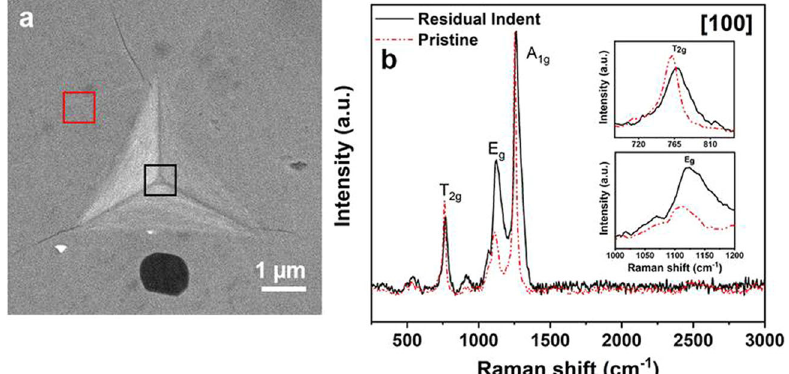
Fig. 2 Raman spectroscopy characterization of pristine and deformed EuB 6 . a SEM image shows Berkovich-indented impression at applied of 70 mN on square cuboid ([100] orientation) of EuB 6 . Here, the square boxes illustrate the regions from which the micro-Raman spectra acquired; black and red boxes represent the residual indent and pristine regions, respectively. b Raman spectra of EuB 6 from residual indent (black line) and pristine (red-dotted line) regions show three major peaks T 2g (768 cm − 1 ), E g (1112 cm − 1 ), and A 2g (1256 cm − 1 ). The enlarged view for T 2g and E g are given in the